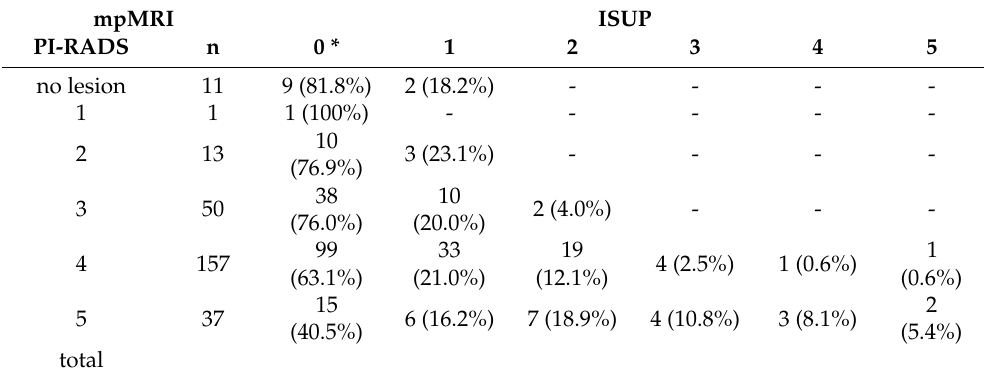
Table 2. Tumor detection via PI-RADS v2 score and ISUP grading.